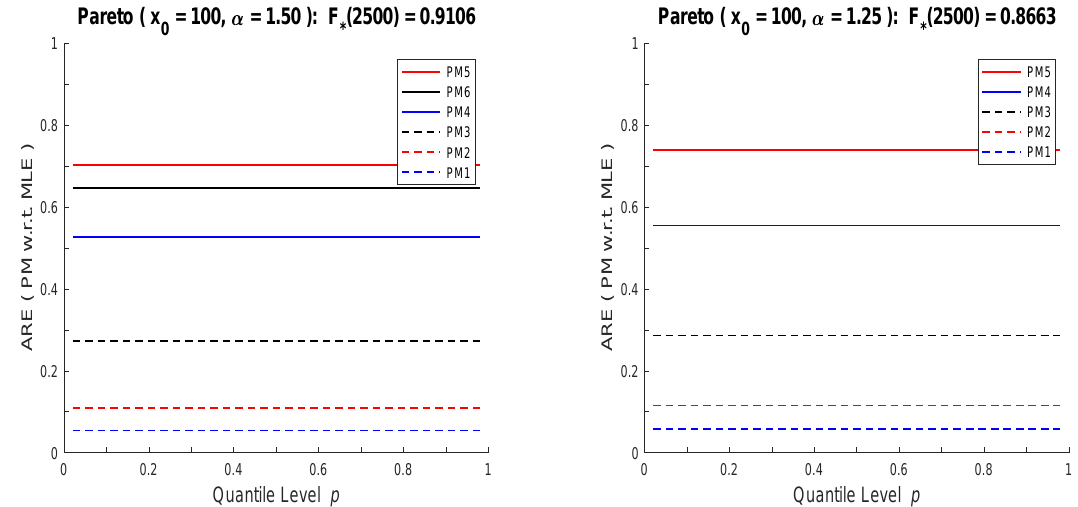
Figure 2. RECs of quantile estimators of the Pareto ( x 0 = 100, α ) distribution for t = 500, u = 2500, Figure 3.2. RECs of quantile estimators of the Pareto ( x 0 = 100 , α ) distribution n = 100, and α = 1.50 ( left column ), α = 1.25 ( right column ). Level p 1 = 0.05 ( PM 1 ), 0.10 ( PM 2 ), 0.25 ( PM 3 ), 0.50 ( PM 4 ), 0.75 ( PM 5 ), 0.90 ( PM 6 ). Top row : Plots of formulas (17) and (18). Bottom row : Plots of for t = 500, u = 2500, n = 100, and α = 1 . 50 (left column), α = 1 . 25 (right column). formula (19). Level p 1 = 0.05 ( pm 1 ), 0.10 ( pm 2 ), 0.25 ( pm 3 ), 0.50 ( pm 4 ), 0.75 ( pm 5 ), 0.90 ( pm 6 ). Top row : Plots of formulas (3.10) and (3.11). Bottom row : Plots of formula (3.12).